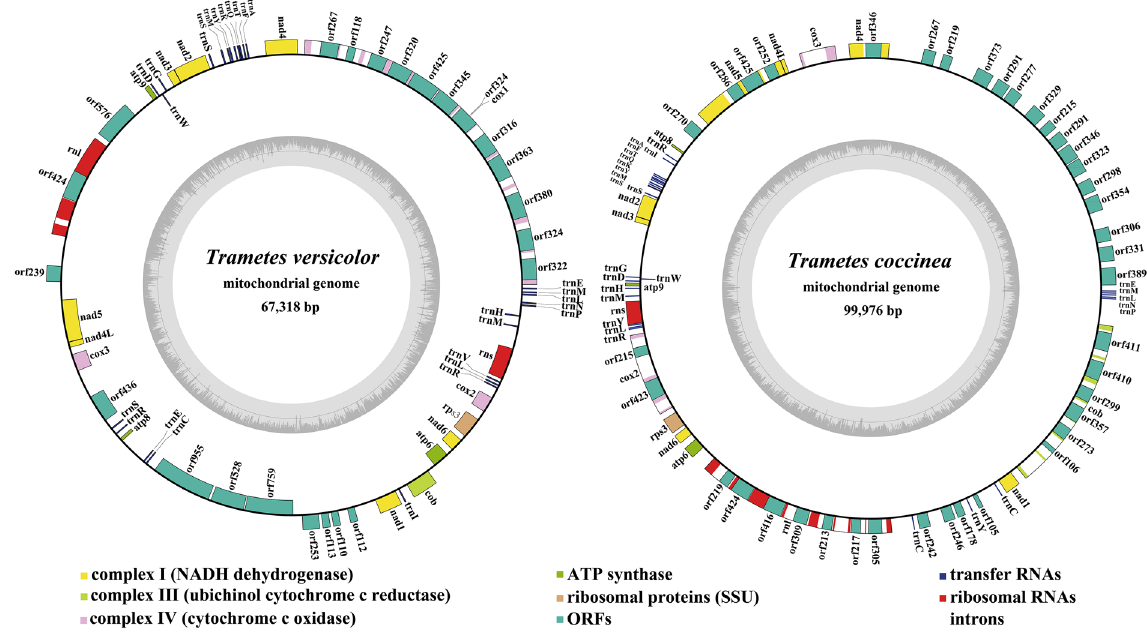
Figure 1. Circular maps of the two Trametes mitogenomes. Genes are represented by different colored blocks. Colored blocks outside each ring indicate that the genes are on the direct strand, while colored blocks within the ring indicates that the genes are located on the reverse